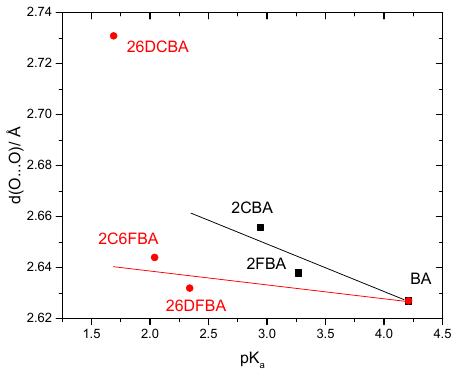
Figure 23. Intramolecular d(O … O) distances in the dimers existing in the crystals of the studied compounds [20–24,30] vs. pK a values (water; 25 °C).